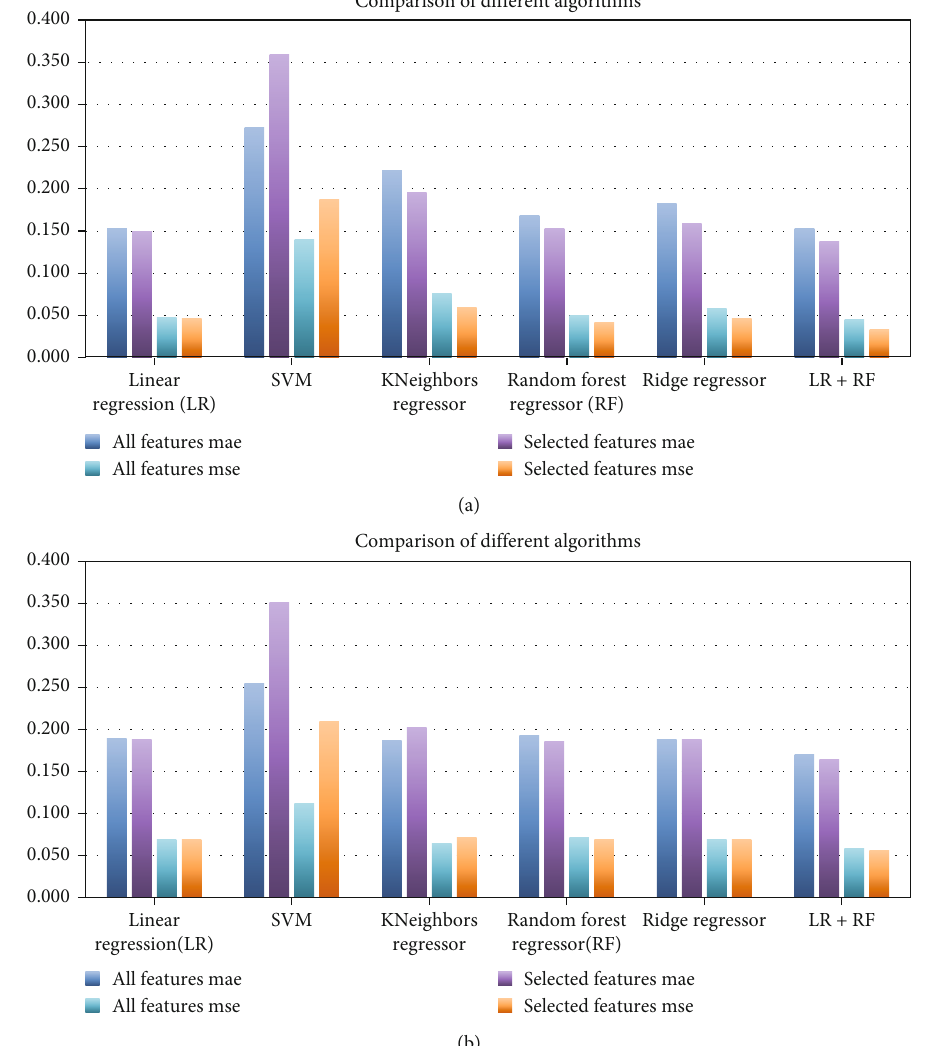
Figure 4: Comparison of VA and VA variance predictions in di ff erent models. The plot showed the performance of the di ff erent algorithms for the VA (a) and VA variance (b) prediction